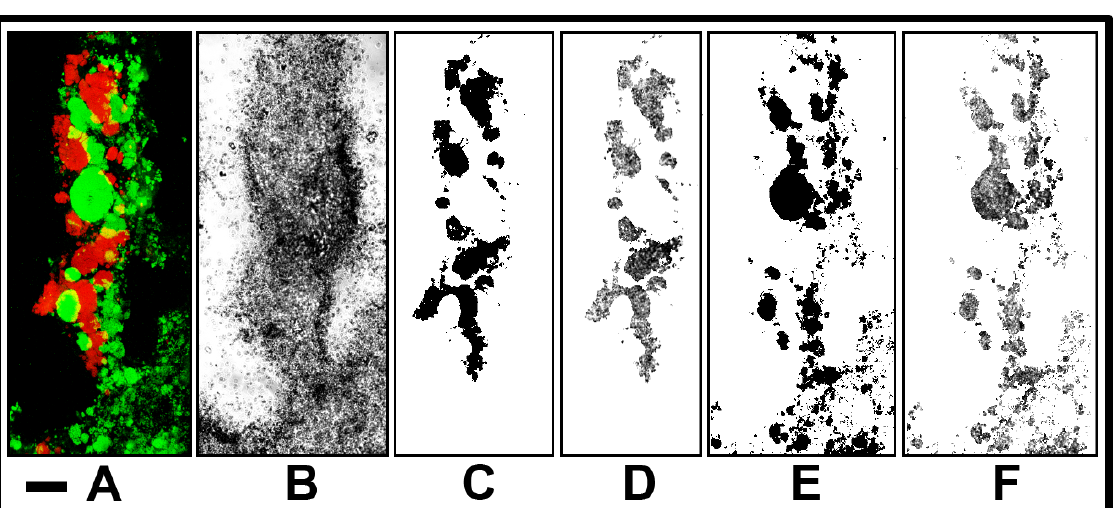
Figure 14. Application of CMEIAS color segmentation to process images for in situ FISH-MAR in a flattened stack of confocal images of a nitrifying biofilm in a wastewater treatment bioreactor. ( a ) Multiprobe FISH image of Nitrospira (red) and other ammonia oxidizers (green). Bar is 10 μm. ( b ) Microautoradiography (MAR) image of active utilization of ( 14 C)-pyruvate by microbes in the same biofilm. ( c , e ) Binary images of the red ( c ) and green ( e ) fluorescent ribotypes derived from the multiprobe FISH image. ( d , f ) Accurately segmented grayscale images of silver grain density corresponding to the two distinct ribotypes isolated from the original MAR image. Images are modified from